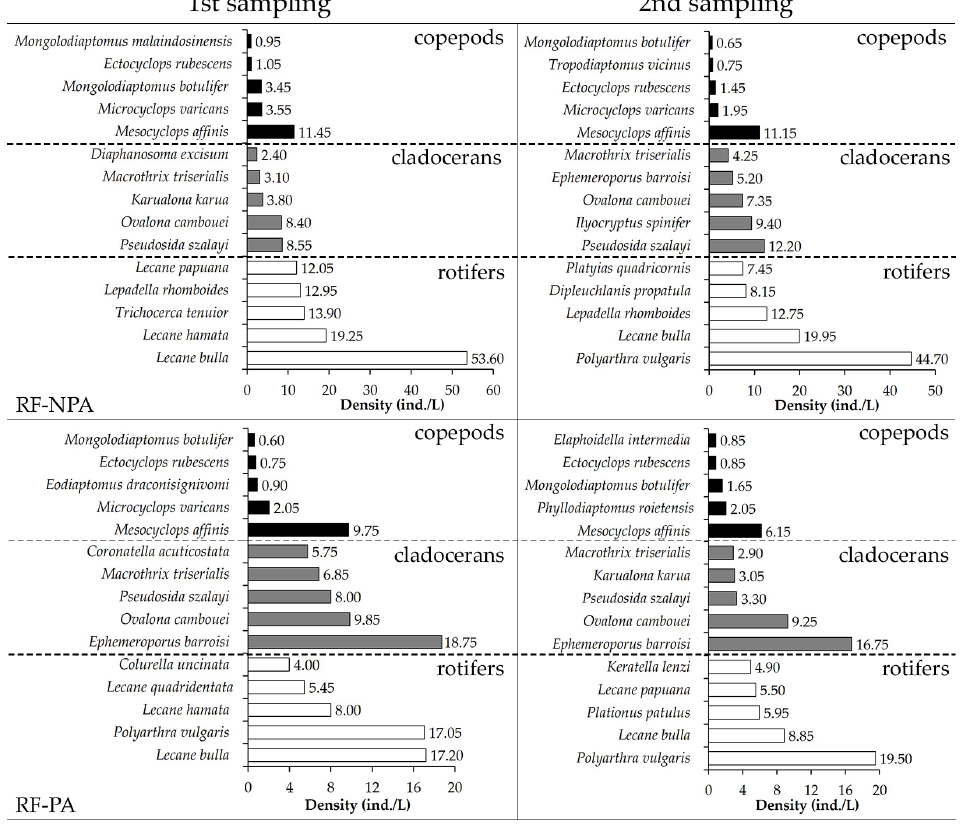
Figure 5. Highest ranking of five dominant zooplankton in RF-NPA and RF-PA at two sampling times.